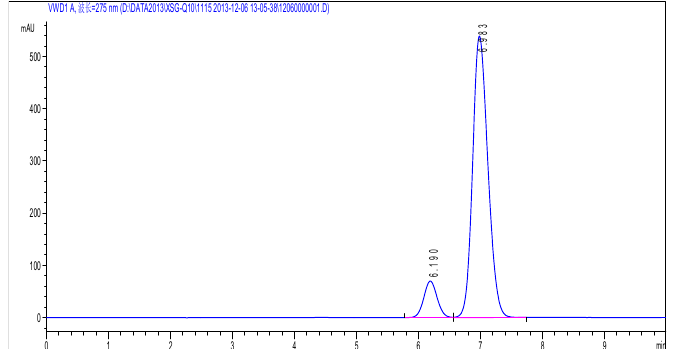
Figure 15. System suitability spectrum of an Agilent RX-SIL column.